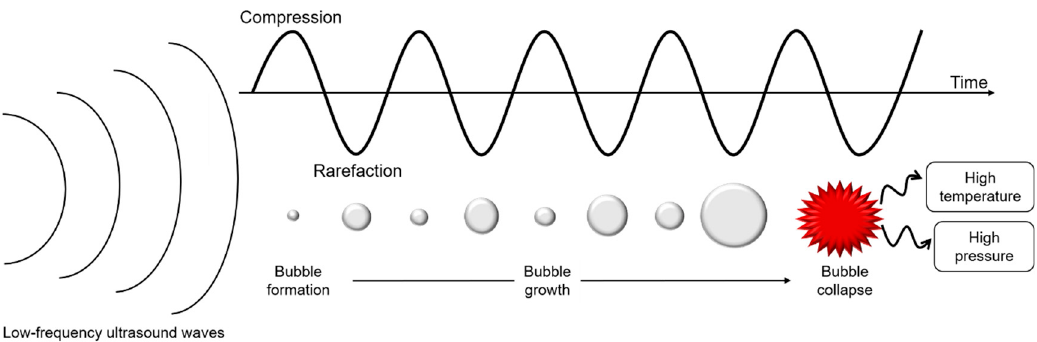
Figure 4. Schematic representation of cavitation phenomenon under low ‐ frequency ultrasounds treatment.